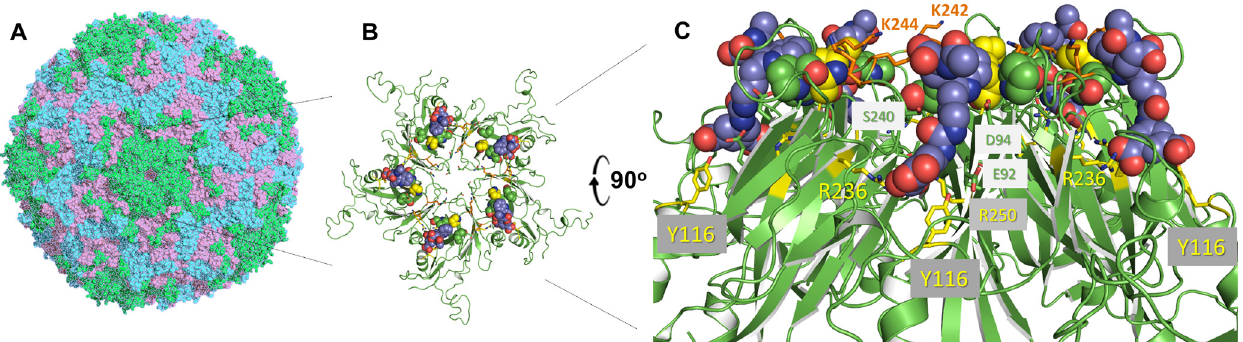
Figure 3. Proposed high-affinity binding site in EV-A71 of the L -Trp unit, alkylurea linker, and isophthalic acid moiety of 23 ( AL-534 ). ( A ) Simplified spacefill model of the EV-A71 capsid (PDB entry 3VBS) showing VP1, VP2, and VP3 subunits colored in green, cyan, and pink, respectively (VP4 is hidden from view). ( B ) Cartoon representation of VP1 (C atoms in green), as found in the fivefold vertex of the EV-A71 capsid, and consensus binding location of five separate legs of 23 ( AL-534 ) (all shown as CPK models with C atoms colored in violet), each one at a subunit interface. For reference, the side chains of amino acids at positions 98 (B–C loop) and 145 (D–E loop) lining the pore are displayed as sticks; the positively charged Lys242 and Lys244 are also displayed as sticks with C atoms colored in orange; Pro96, Pro142, and Pro246 are displayed as spheres, with the C atoms of Pro246 in the H–I loop colored in yellow. ( C ) Zoomed view showing one binding site in greater detail and the side chains of Glu92, Asp94, Tyr116, Arg236, Ser240, and Arg250, all of which are in close proximity to the ligands, shown as sticks and labeled.